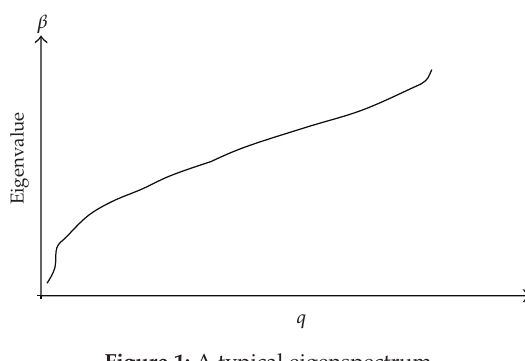
Figure 1: A typical